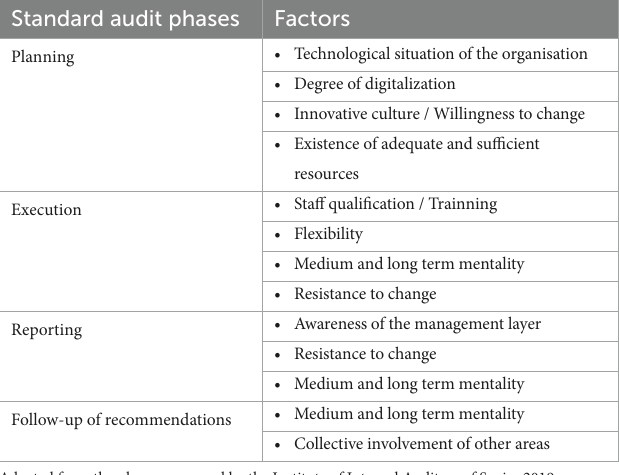
TABLE 4 Factors to consider in the successful implementation of data